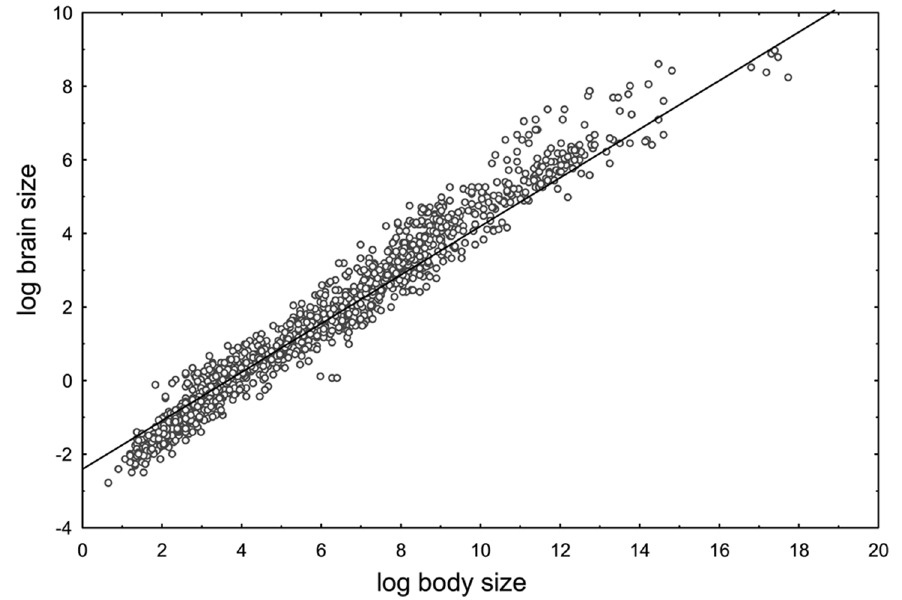
Figure 1. The allometric relationship between the brain and body sizes in 1309 mammalian species. Because the families were represented by an unequal number of data points (species), each family was given an equal weight when calculating the ordinary least-square regression. This correction for biased representation of the families resulted in a line seemingly unfitting the data points (representing species and not families). This adjusted regression line is considerably more reliable for further GLM analyses performed between family level, though. Allometric